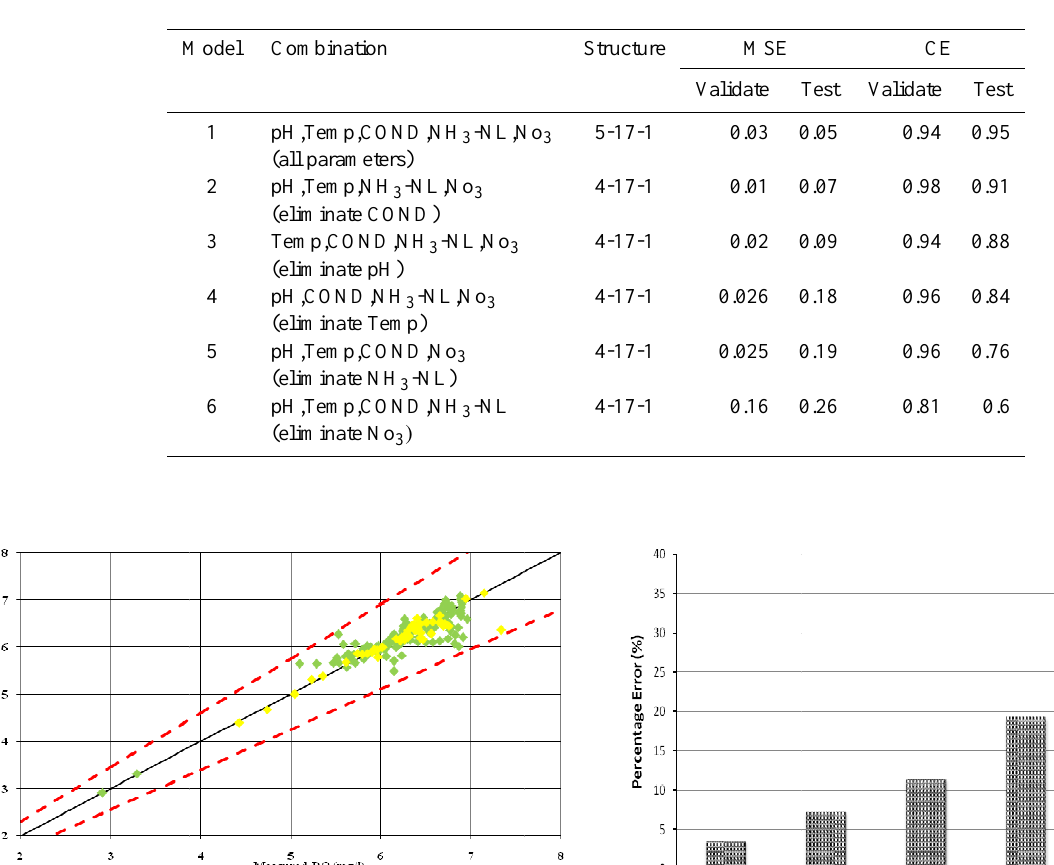
Table 4. Predictive accuracy if any one of the input parameters was removed from model.